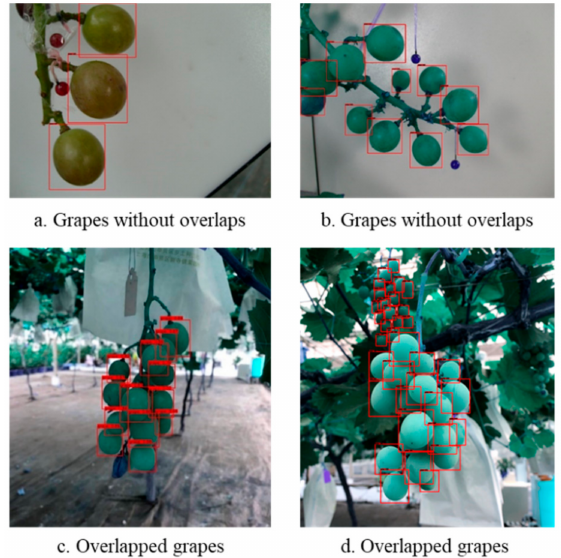
Figure 11. Detection of grape particles.